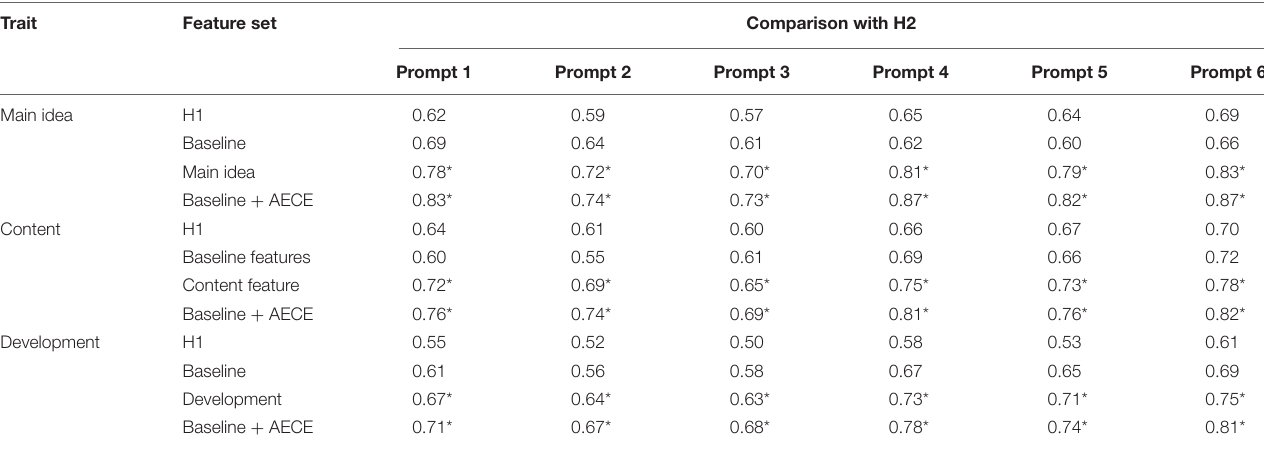
TABLE 4 | QWK of feature sets on trait scoring (main idea, content, and development) on the six data sets. Trait